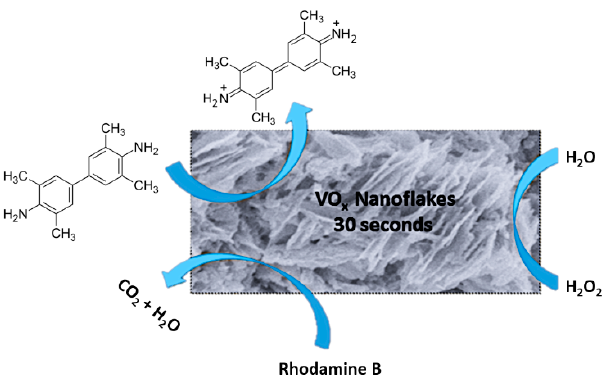
Figure 21. VO x nanoflakes as efficient catalysts for the oxidation of TMB and decomposition of Rh B. (Adapted with permission from [179] . Copyright © 2016, American Chemical Society).